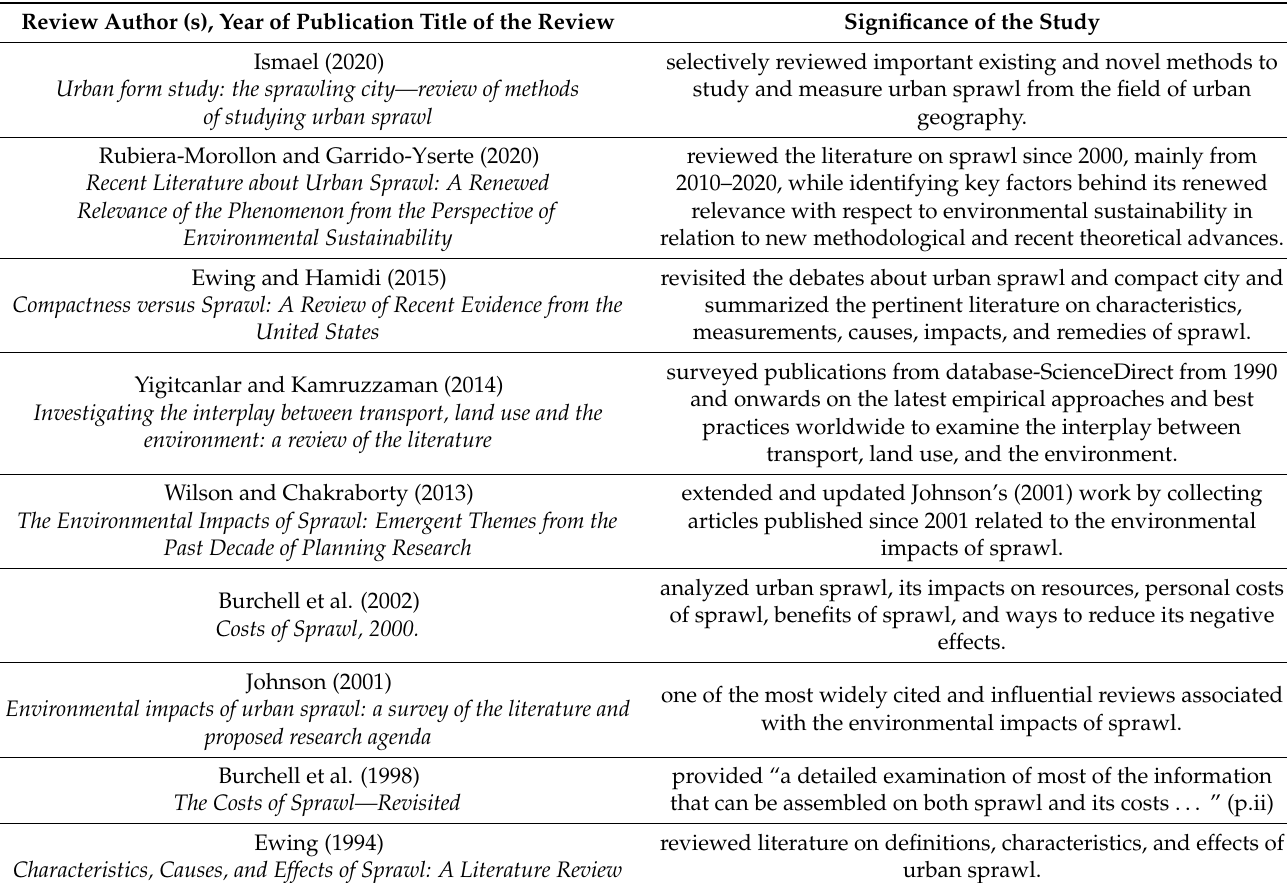
Table 1. Reviews of either urban sprawl, the environmental impacts of urban sprawl, or